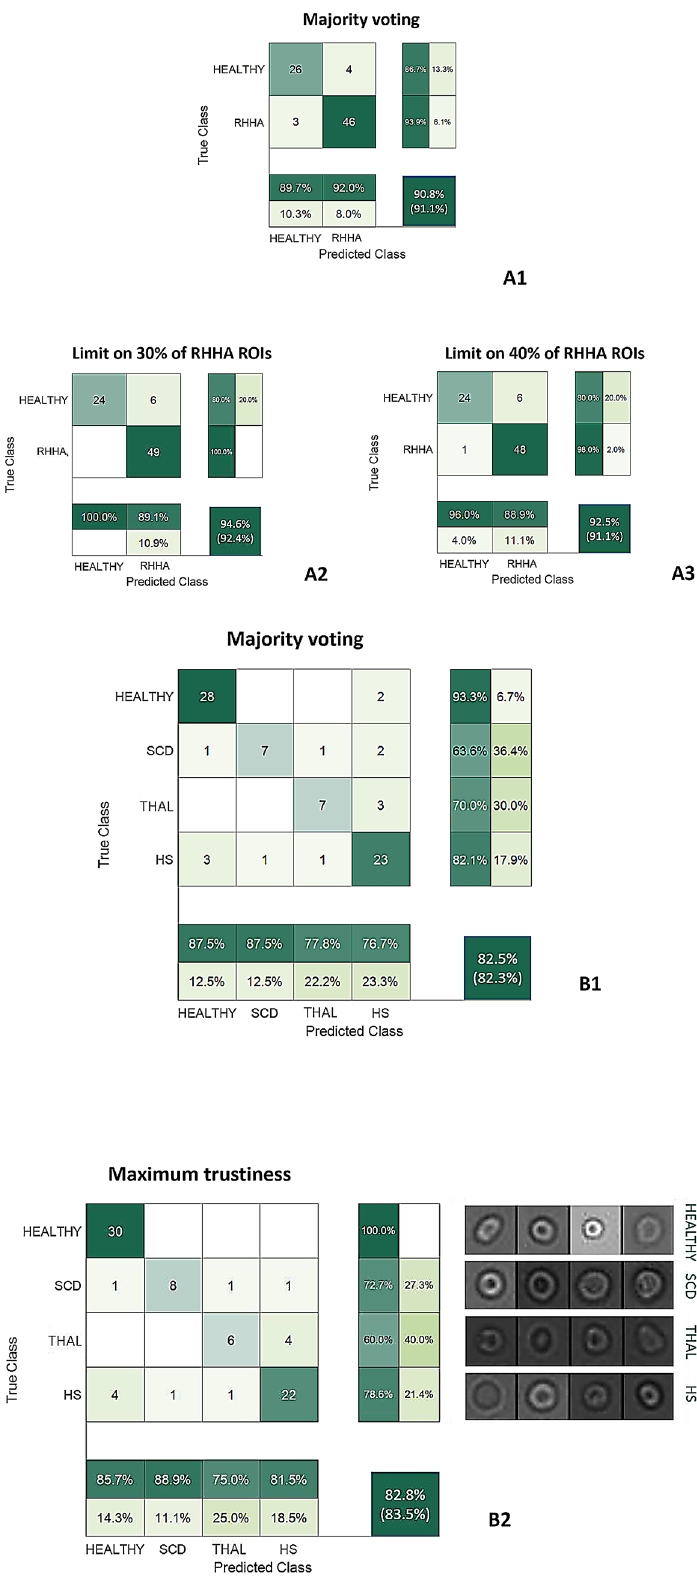
Figure 3. Confusion matrices. ( A1 ) Confusion matrix reporting the results of the majority voting for the two-class problem. ( A2 – A3 ) Confusion matrices reporting the unhealthy percentage limit criteria for the two- class problem. ( B1 – B2 ) Confusion matrices reporting the results of the majority voting and of the maximum trustiness criteria for the four-class